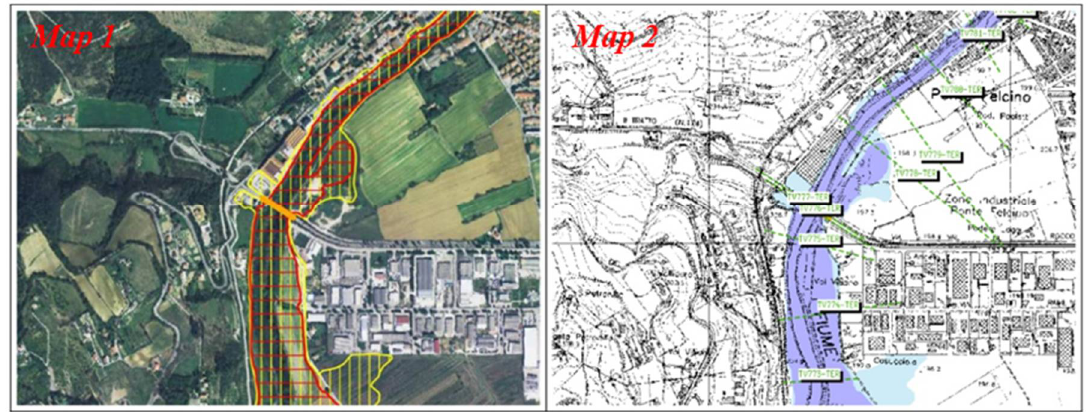
Figure 14. View of Section 2 details: flooding limits for different return period ( map 1 ), areas “A” and “B” ( map 2 ).